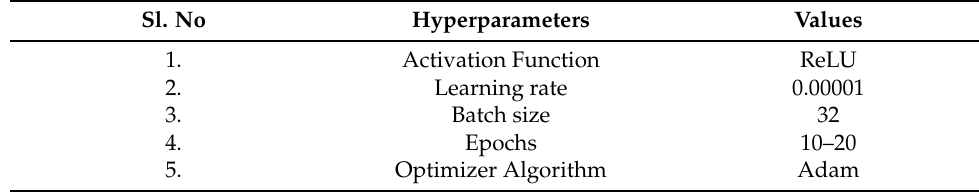
Figure 6. Layers of optimized CNN model. Table 3. Optimized CNN hyperparameter